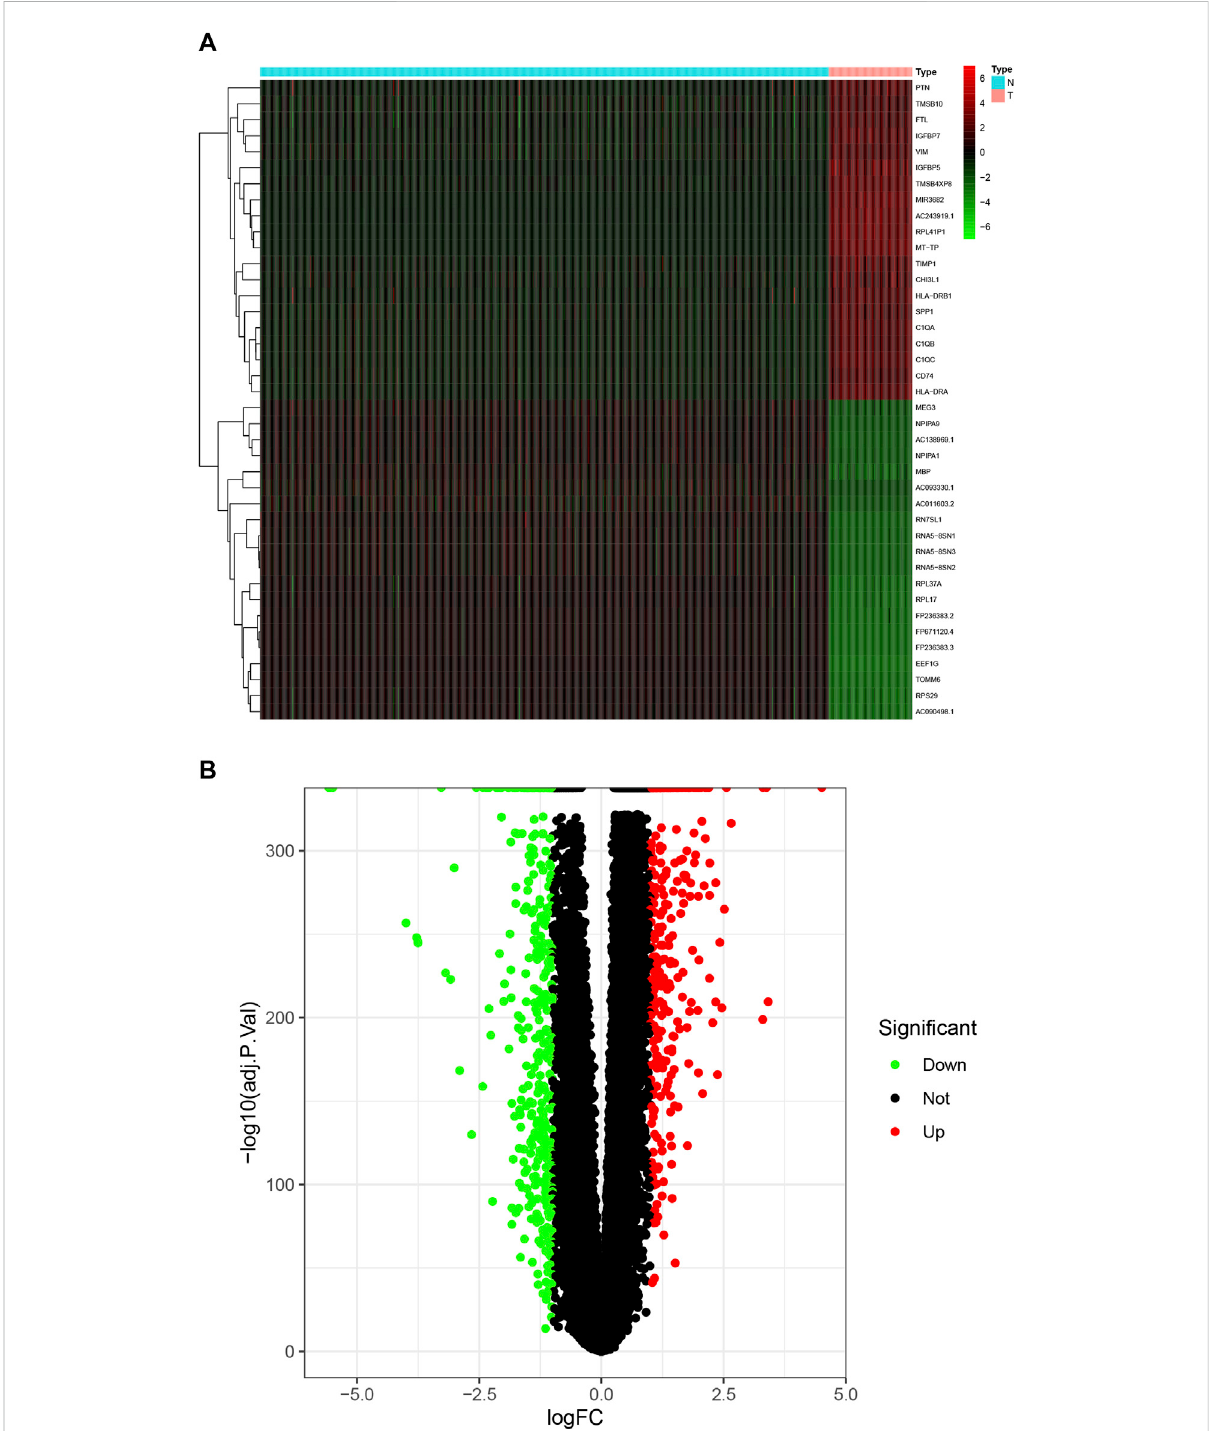
FIGURE 3 DEGs in GBM. (A) Heat maps of the top 50 DEGs in GBM; (B) the DEGs volcano plot in GBM. DEGs, differentially expressed genes; GBM, glioblastoma